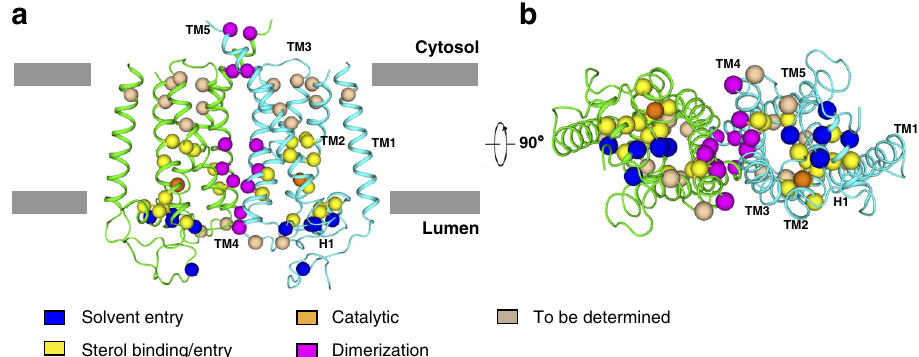
Fig. 5 The locations of Conradi – Hunermann syndrome mutations. a Overall structure of EBP with disease-related mutations viewed parallel to the membrane . b The bottom view. The α carbon atoms of representative disease-related residues are shown as spheres. Color code for mutations: blue, solvent entry; yellow, sterol binding/entry; orange, catalytic sites; magenta, dimerization; wheat, structural consequences yet to be determined.